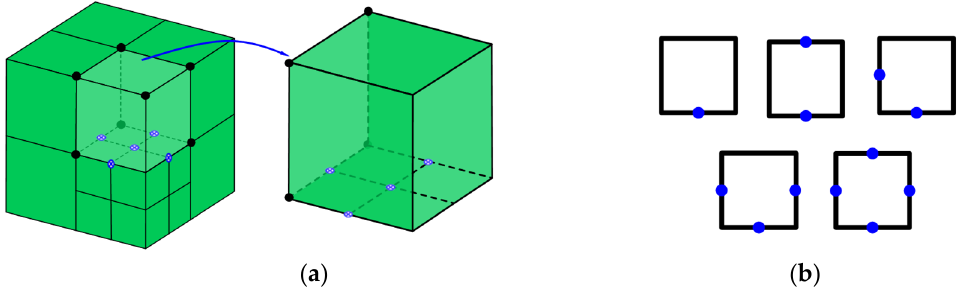
Figure 1. Octree polyhedral elements. ( a ) Octree mesh; ( b ) Polygonal surfaces.